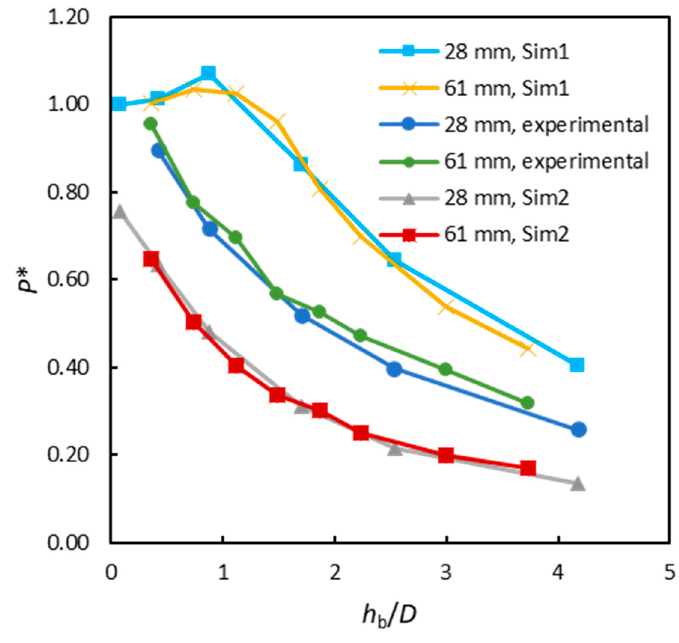
Figure 4. Dimensionless version of the two previous plots, for both columns.